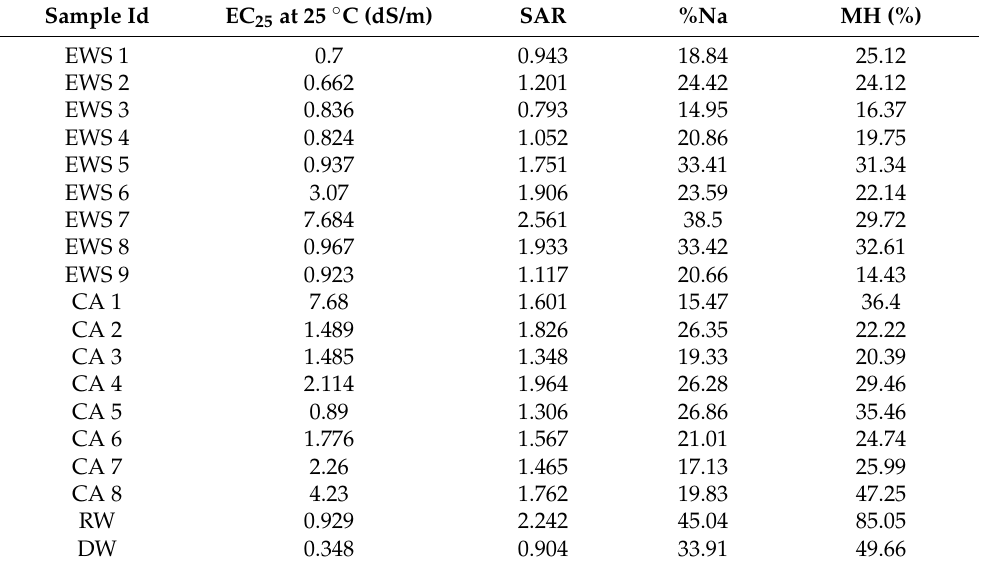
Table 3. Computed irrigation parameters for groundwater, river water, and dam water samples in Gumselasa